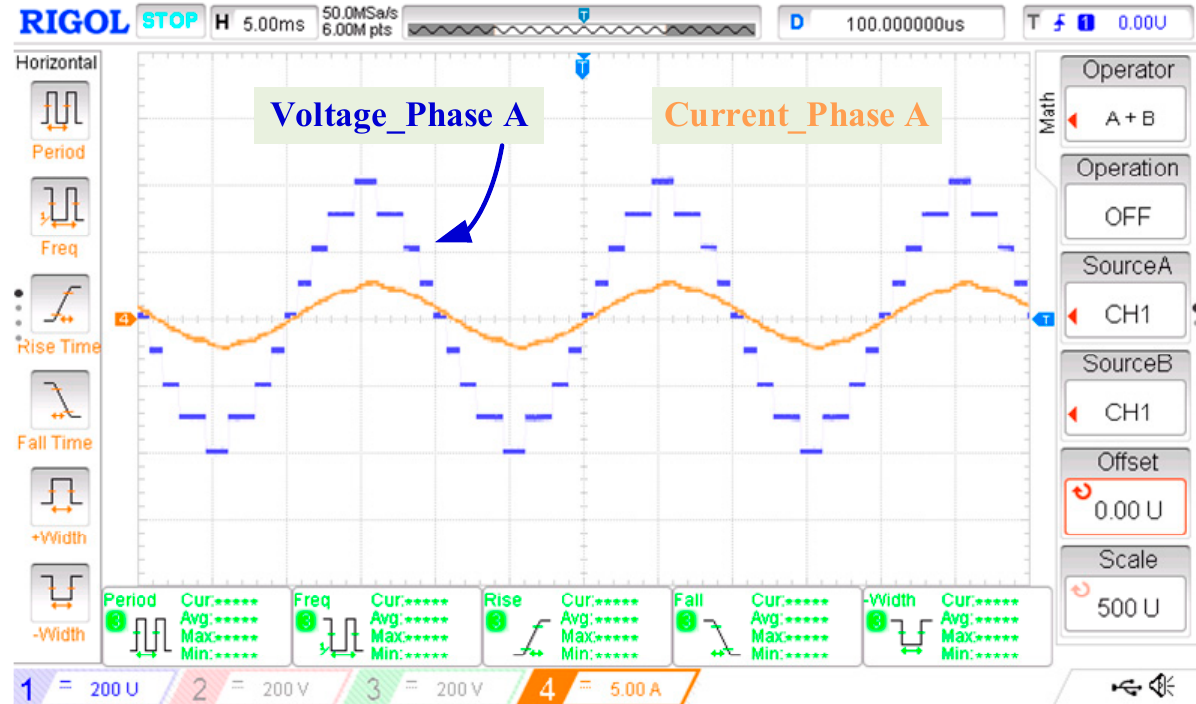
Figure 16. HIL result: voltage and current waveform for RL load.